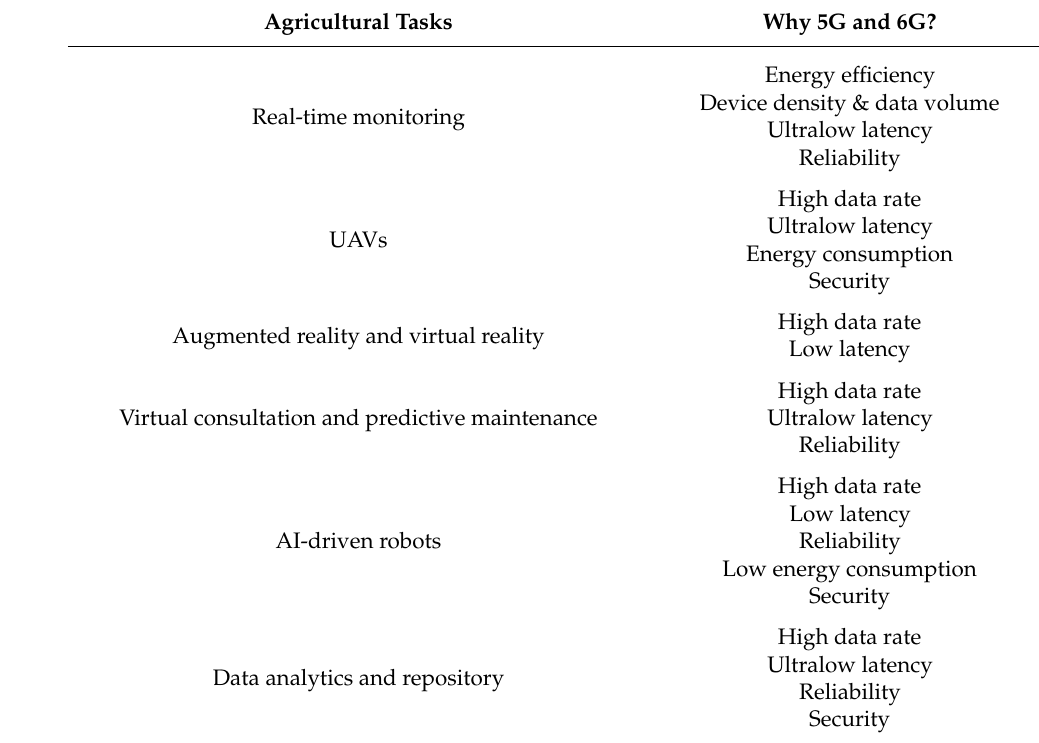
Table 1. Exploration of 5G and 6G technology in agricultural